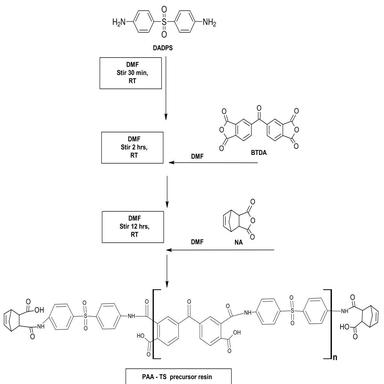
The synthesis scheme of the PAA-TS precursor resin.